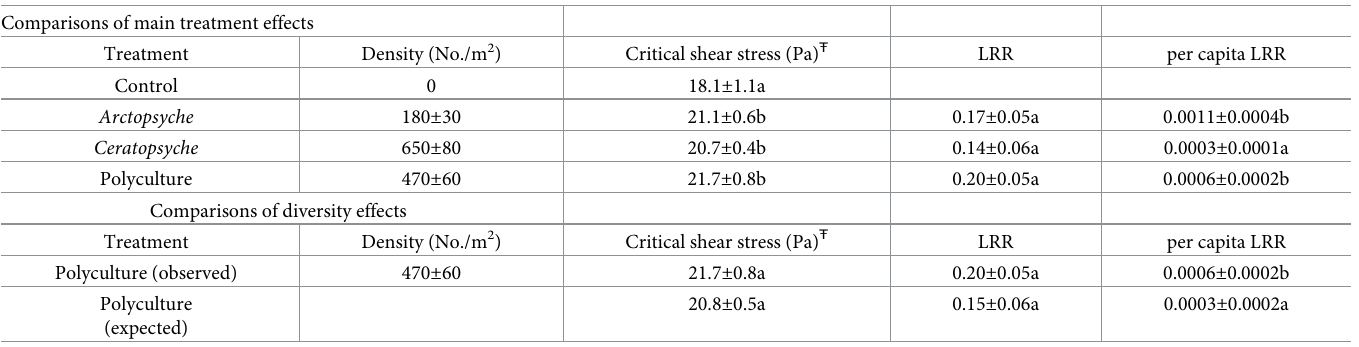
Table 2. Results from the